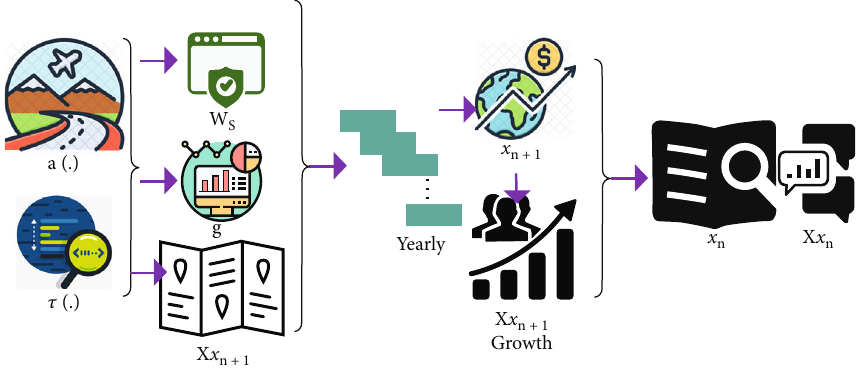
Figure 3: Growth rate